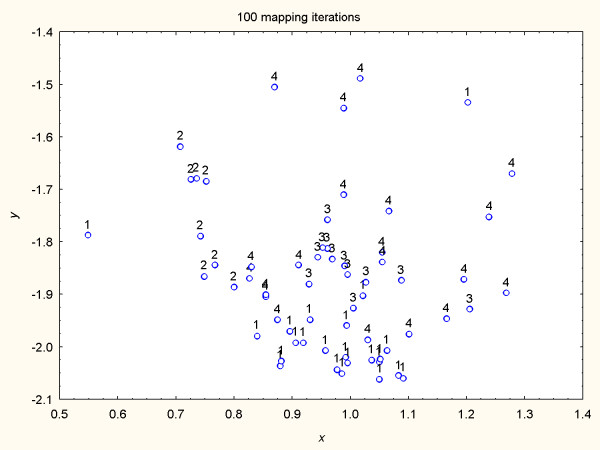
Resulting maps for the SRBCT data. EWS, RMS, BL and NB samples are represented by symbols '1', '2', '3' and '4' respectively. 100 mapping iterations.